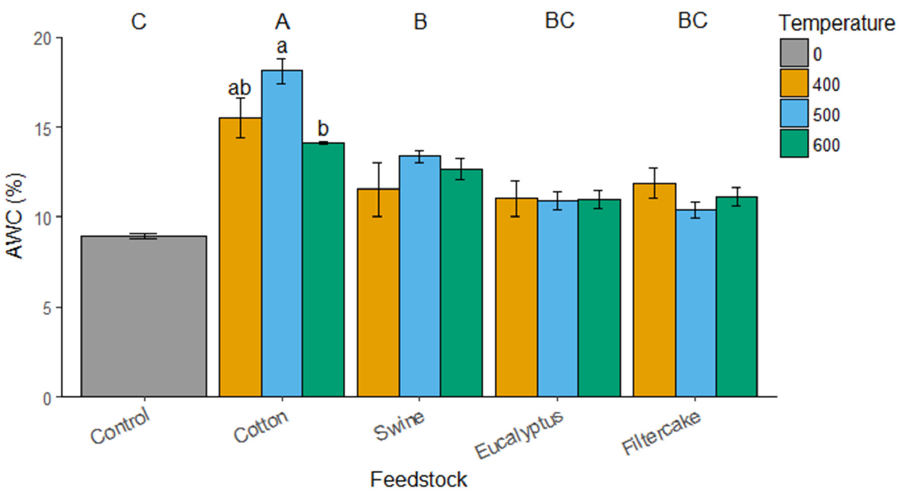
Figure 4. Water retention curves of intact soil cores ( n = 4).